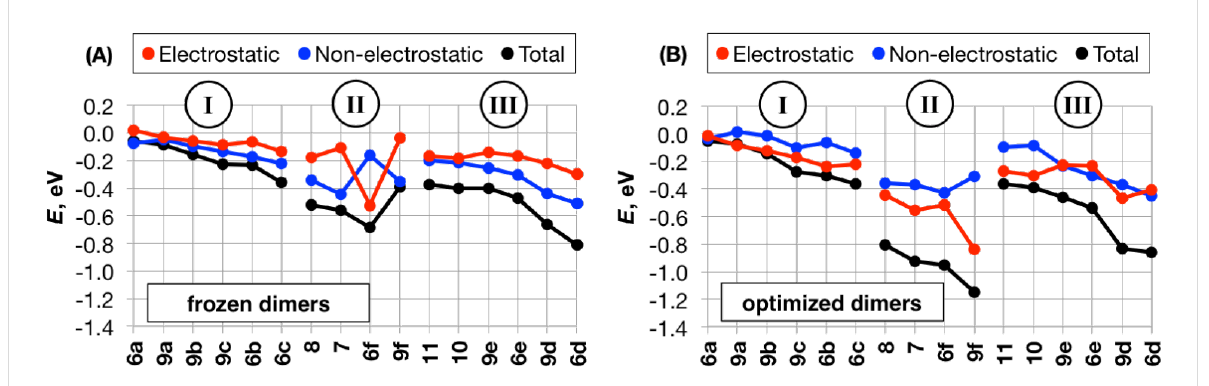
Figure 3: Breakdown of the SAPT0/jun-cc-pVDZ total interaction energies into electrostatic and non-electrostatic contributions in frozen (A) and opti- mized (B)